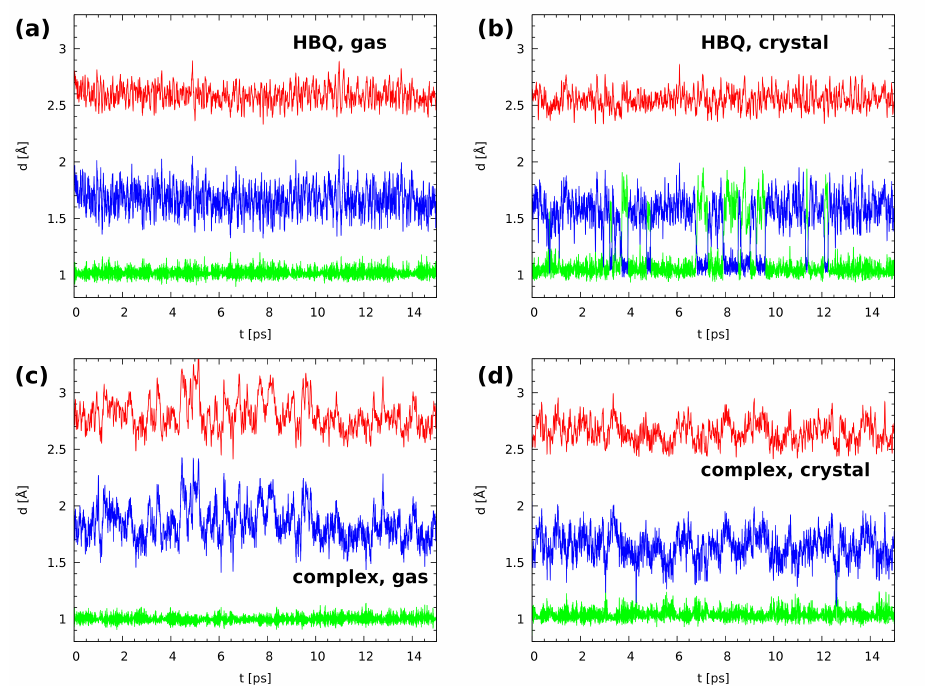
Figure 3. Time evolution of the metric parameters of the O-H...N hydrogen bridges in the inves- tigated systems. ( a ): HBQ in the gas phase, ( b ): HBQ in the crystal, ( c ): the benzo[h]quinoline-2- methylresorcinol complex in the gas phase, ( d ): the complex in the crystal. Color coding of the graphs: red—d(O...N), green—r(O-H), blue: